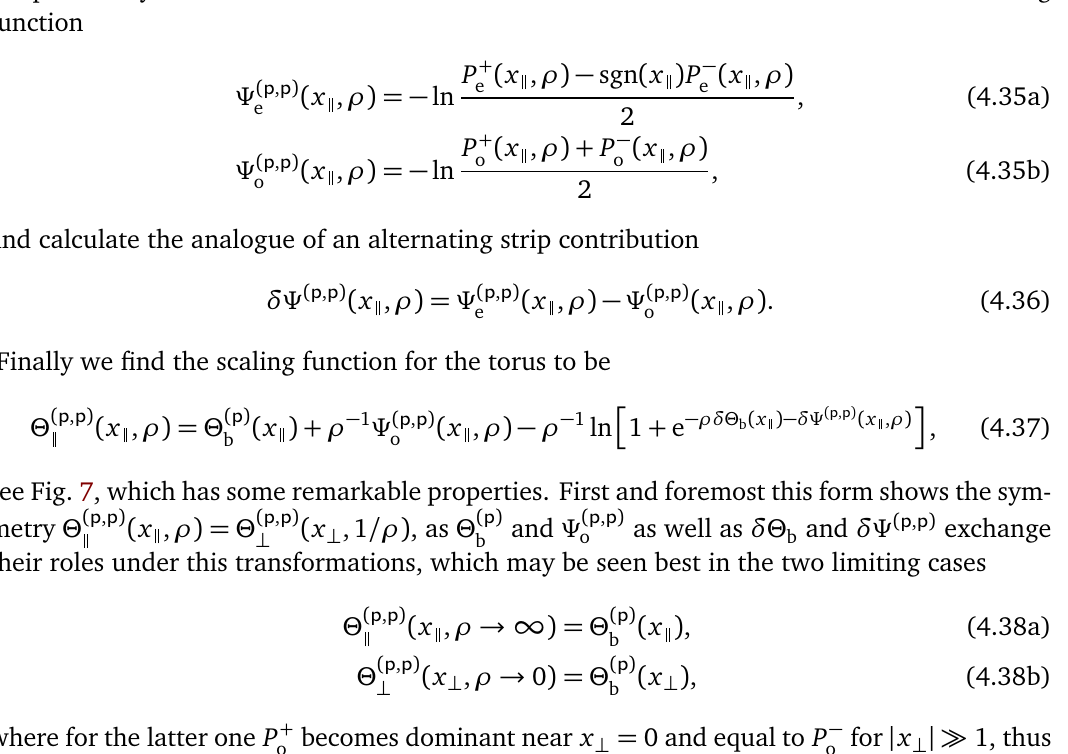
Figure 7: Scaling function Θ Due to the periodic BCs the system has the symmetry Θ The limit (4.39) for x δ → −∞ due to the degeneracy is shown for corresponding values of ρ as dotted